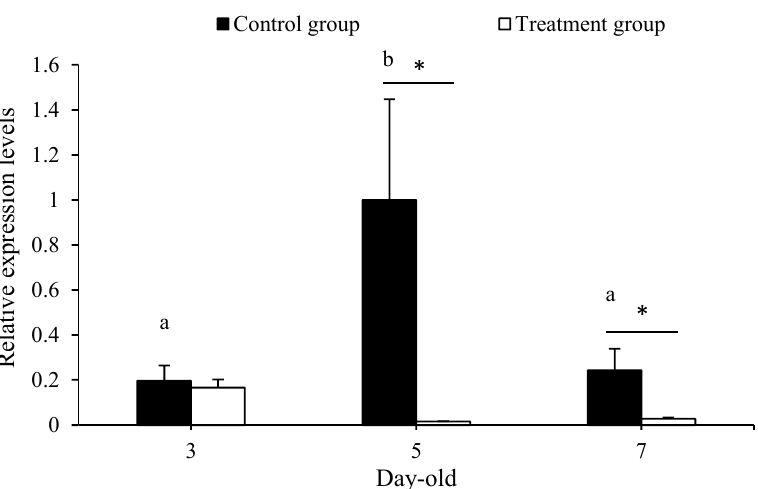
Figure 1. Antibiotics treatment effect on the amount of gut bacteria in larvae of different ages. The different letters on the error bars indicate the significant differences in gut bacteria amount among the 3-, 5-, and 7-day-old larvae at the 0.05 level. (Tukey’s test). The asterisk above the bars indicates a significant difference in gut bacteria amount between the treatment and corresponding control (* for p < 0.05).